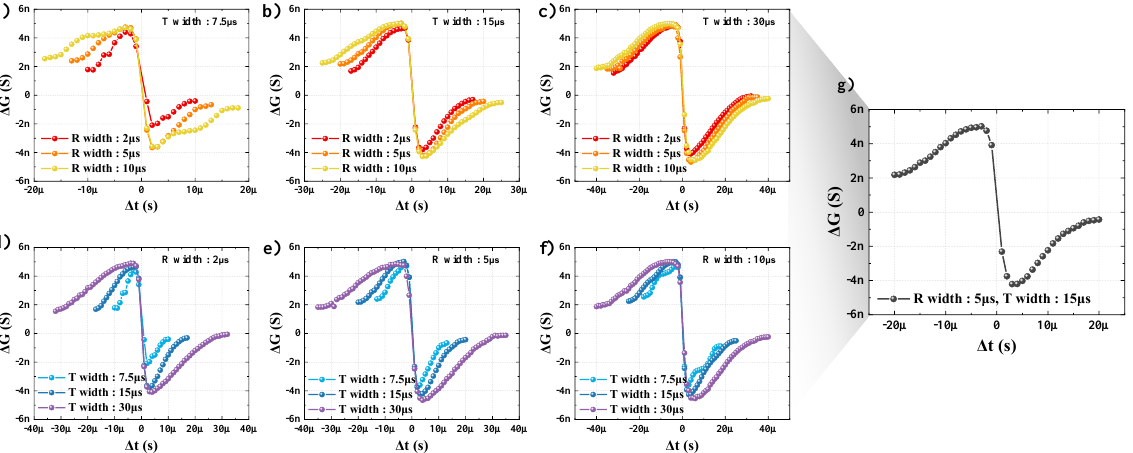
Figure 4. Multiple conductance characteristics with STDP Learning. ( a – c ) ΔG–Δt graph as function of R. ( d – f ) ΔG–Δt characteristic curve as function of T. ( g ) ΔG–Δt characteristic curve of optimized spike condition.